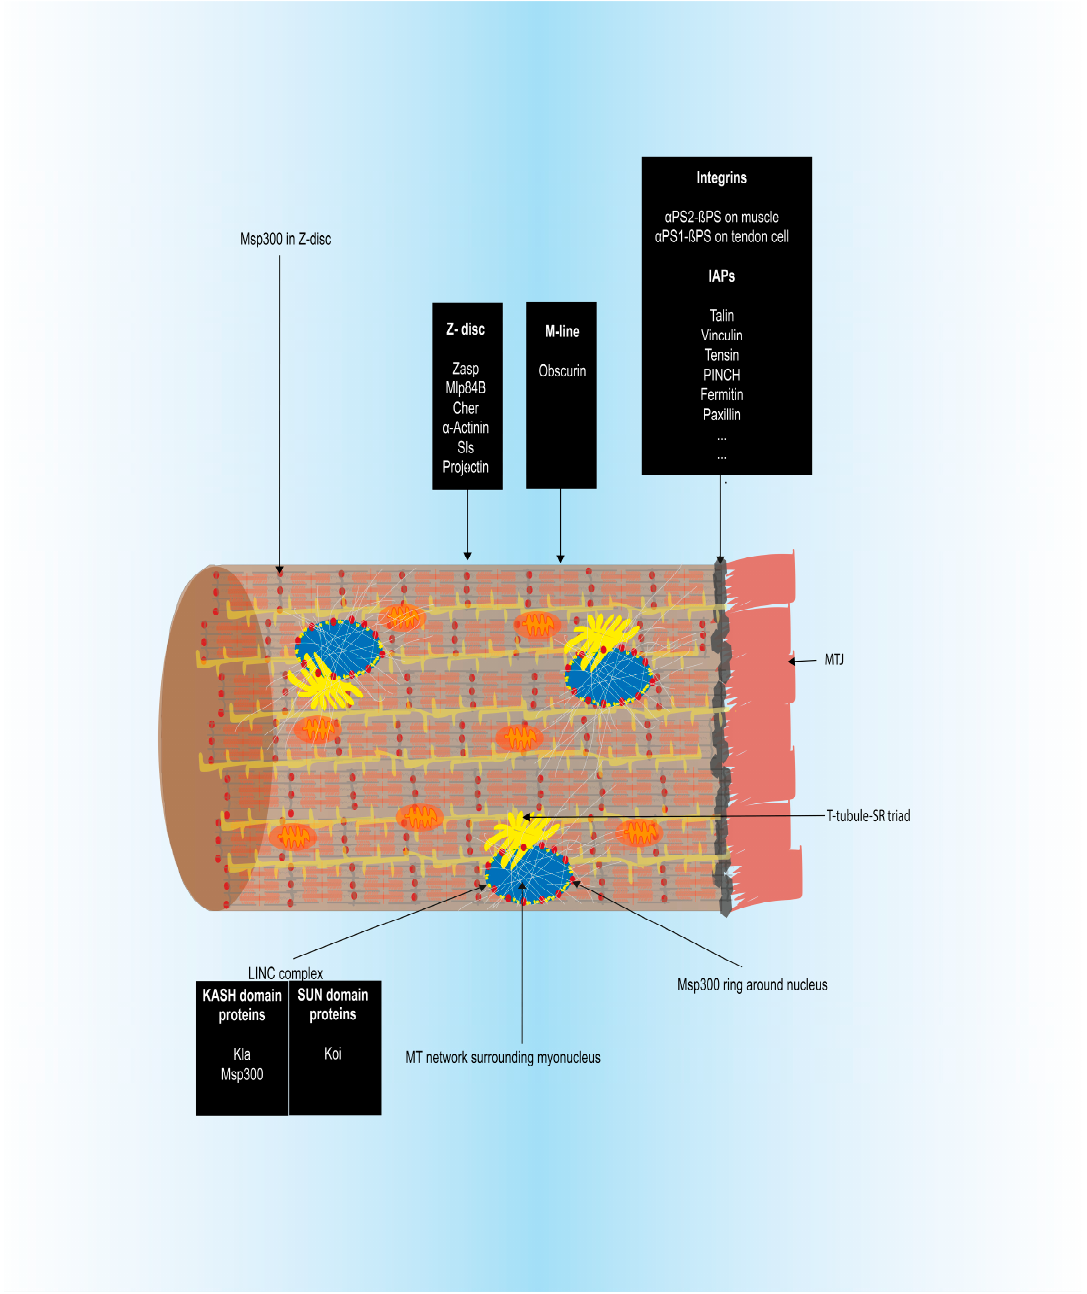
Figure 3. Maintenance of myofibril integrity and homeostasis. The integrin complex links the myofibrils to the MTJ via the extracellular matrix (ECM) and senses the forces transmitted by the MTJ. Integrins and Integrin Associated Proteins (IAPs) constitute the integrin complex. Integrin complex turnover and constitution are adapted to the forces sensed during contraction. The dense microtubule (MT) network anchored to the myonuclei by the Msp300 ring associated with the LINC complex on the nuclear envelope provides myonuclear elasticity during contractions to prevent disintegration of myonuclei and dissociation of the myofibril network. Msp300 in the Z-disc ensure regular spacing of organelles such as mitochondria and the SR for contractions. Z-disc and M-line components provide anchorage and elasticity to ensure sarcomeric